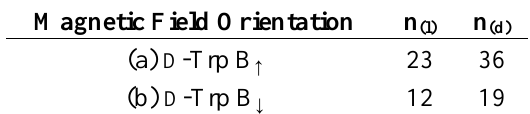
Table 7. Control experiment with only on chiral amino acid: D